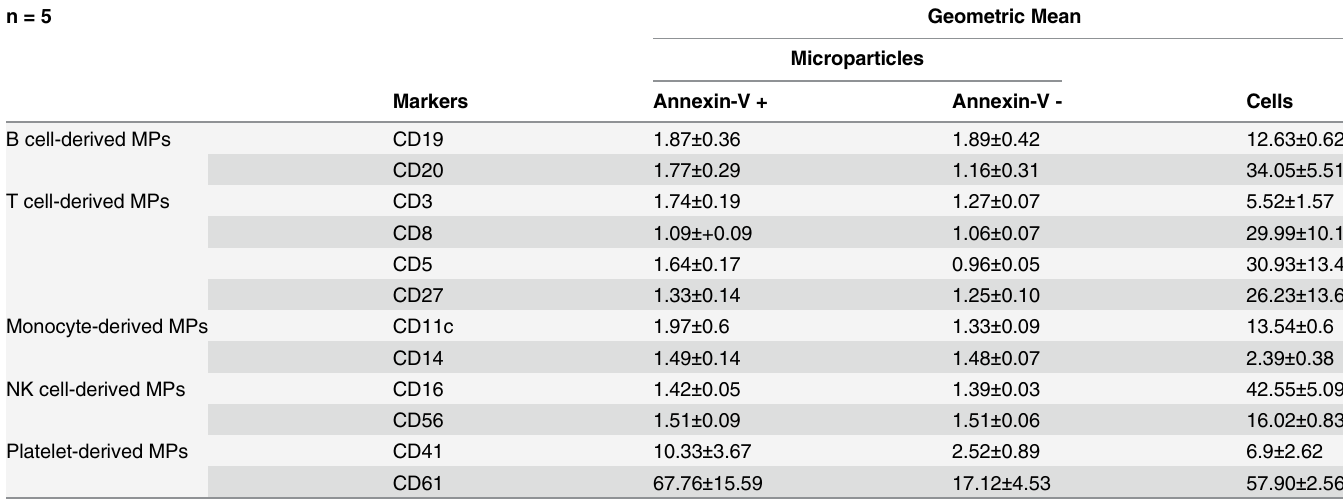
Table 1. Mean fluorescence intensity ratio (MFIR) analysis on MPs by direct flow